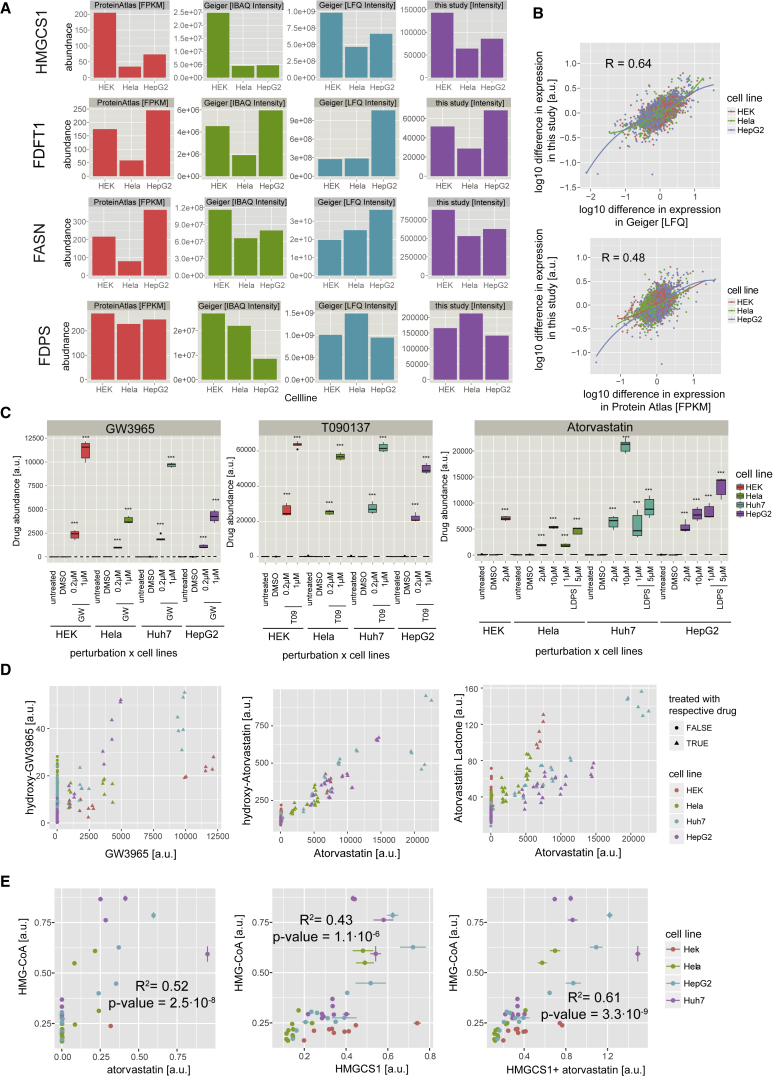
Heterogeneity in Basal Protein Expression, Drug Disposition, and Drug Response(A) Comparison of basal expression in three cell lines (Huh7 cells were not quantified in the other studies and thus omitted). The mRNA levels were measured in the Protein Atlas project (Uhlen et al., 2015) and the protein levels in Geiger et al. 2012 (IBAQ and LFQ quantification).(B) Correlation of relative differences in expression of proteins between this study and other studies (see above).(C) Signal for intracellular drug concentration at 48 hr after treatment is shown for the different drug perturbation conditions and control samples. Adjusted ∗∗∗p < 0.001.(D) Correlation between the signal of intracellular drug metabolites across all samples. The measurements from samples treated with GW3965 or atorvastatin are shown as triangle respectively, other conditions are shown as circles.(E) Correlation between HMG-CoA and either atorvastatin, HMGCS1, or summed HMGCS1 + atorvastatin signal. Signal for all metabolites and proteins were scaled between 0 and 1 and error bars show the SD for three independent biological replicates.